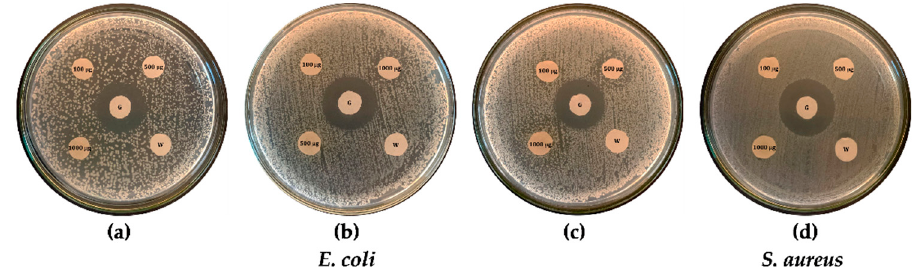
Figure 2. Antibacterial activity of TWCDs obtained with different ED/TW mass ratios (0.08 ( a ), 0.16 ( b ) and 0.32 ( c , d )) in various concentrations (disc diffusion assay); gentamicin (G; 100 µ g/disc) used as positive control and water (W) used as negative control.